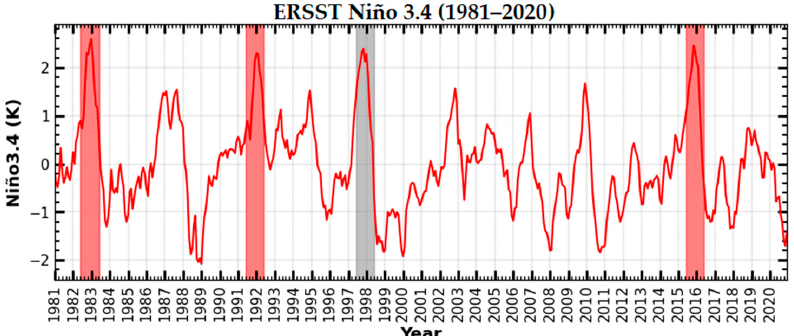
Figure 8. Seasonal cycles of Niño 3.4 from 1981 to 2020. The SST Anomalies were normalized to 1981–2010. The shades of red and gray represent intense El Niño seasons of 1982/83 (red), 1991/92 (red), 1997/98 (gray) and 2015/16 (red).